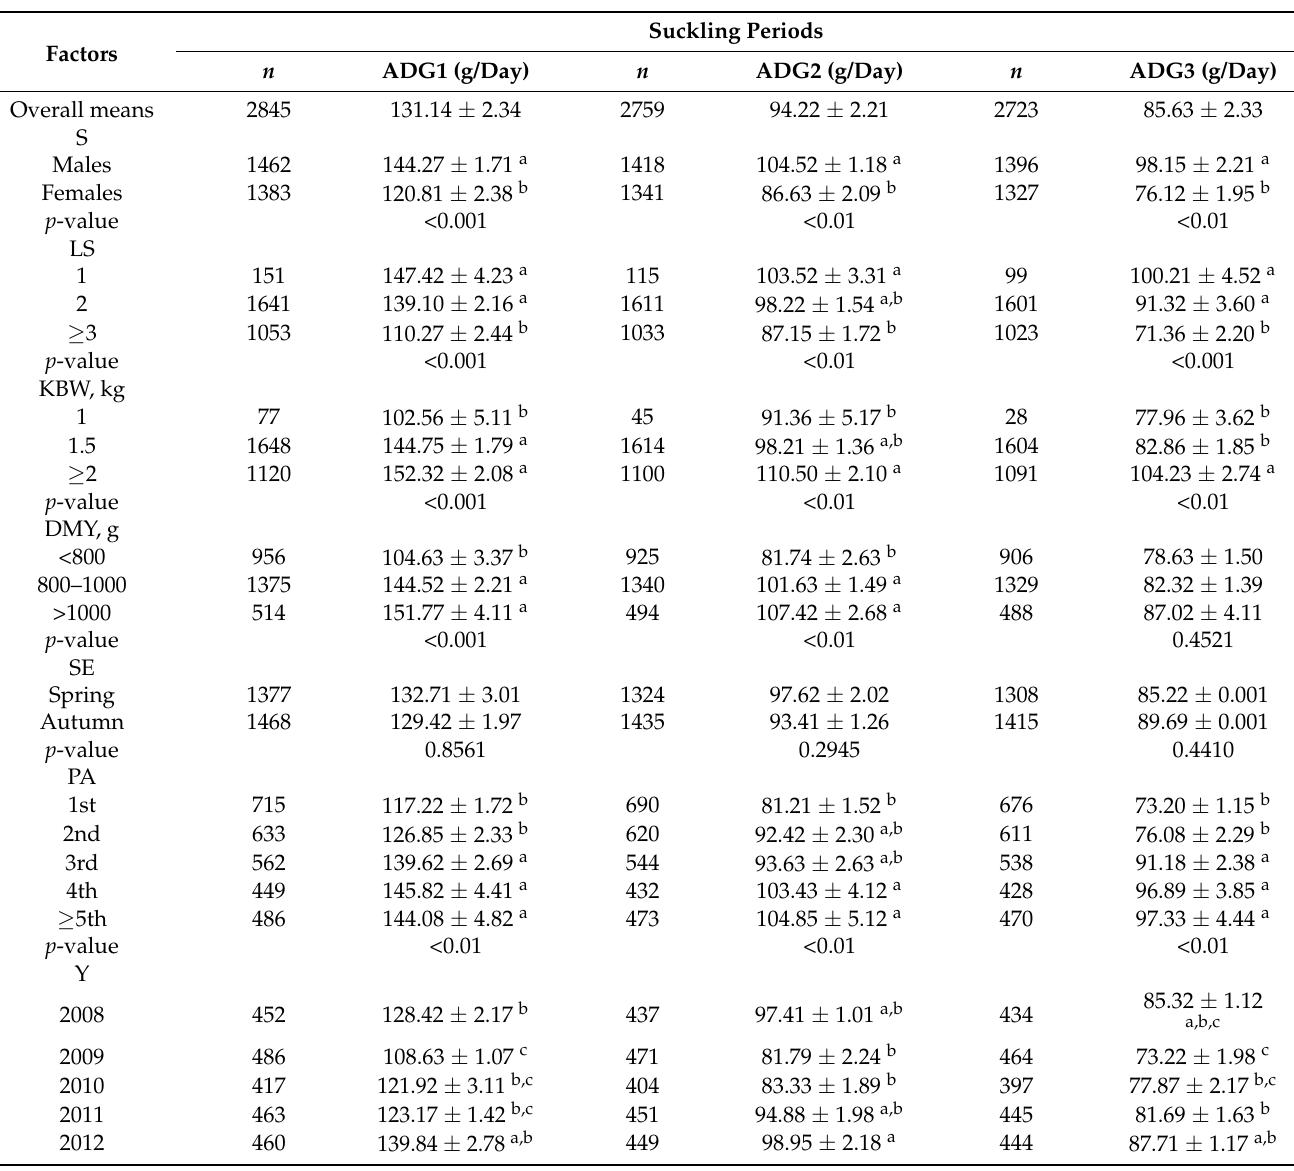
Table 1. Average daily weight gain (ADG) in different categories of fixed factors during different suckling periods (LSM ±